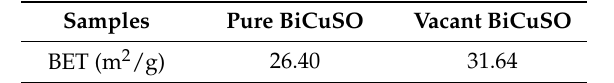
Table 1. The BET (Brunauer–Emmett–Teller) specific surface area of different